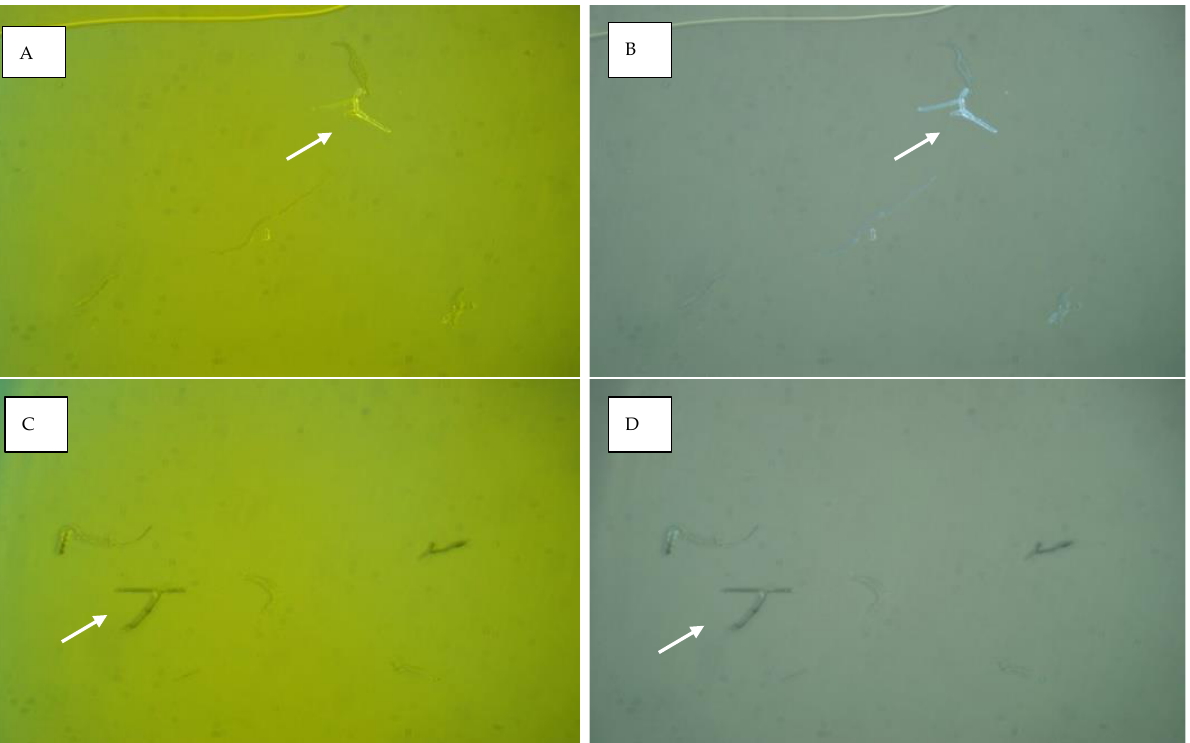
Figure 2. Fluorescence microscopy images of Alternaria alternata: ( A , B ) images of specimen smears after the addition of hydrogen peroxide viewed with fluorescent Filters 1 a and 2 b , respectively; ( C , D ) images of the same specimen, viewed with fluorescent Filters 1 a and 2 b , respectively, without the addition of hydrogen peroxide. Images were recorded under ×200 magnification. a Filter 1 features: barrier (LP) 520 nm, excitation 450 – 90 nm, and emission 510 nm. b Filter 2 features: barrier 420 nm, excitation 365 nm, and emission 395